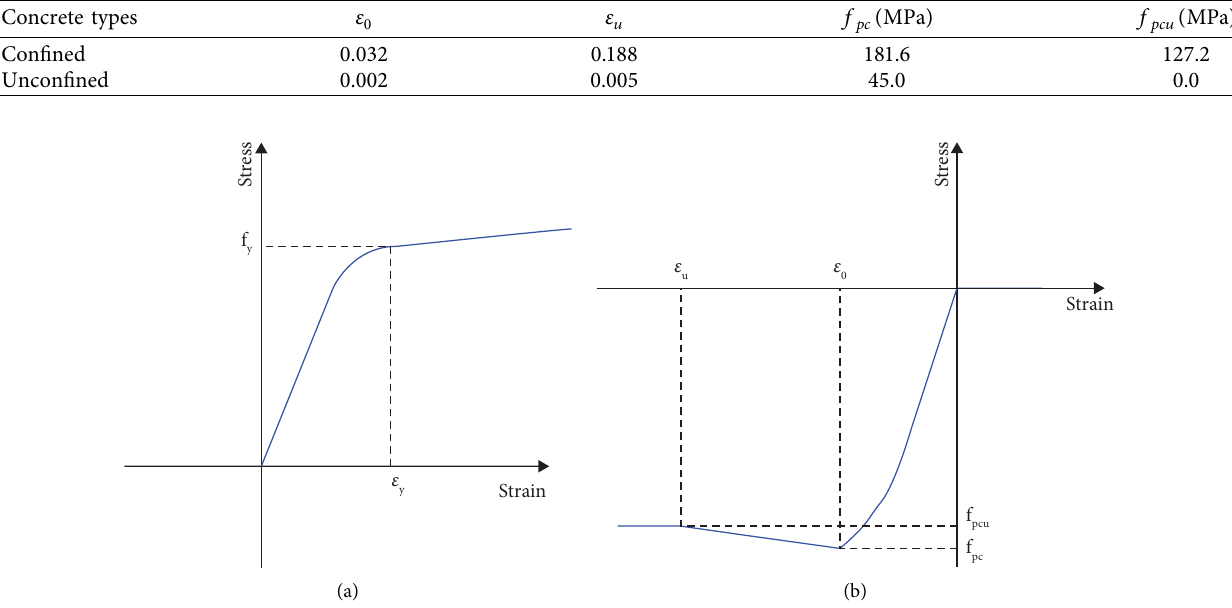
Table 4: Nonlinear properties of confned and unconfned concrete.